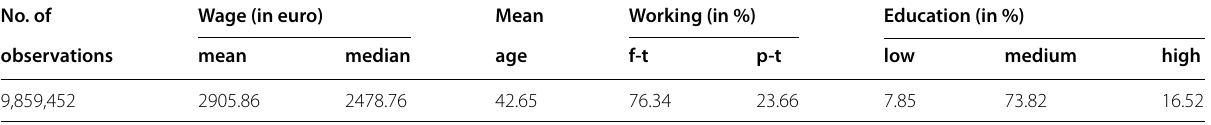
Table 7 Summary statistics SIAB: comparable sample 1